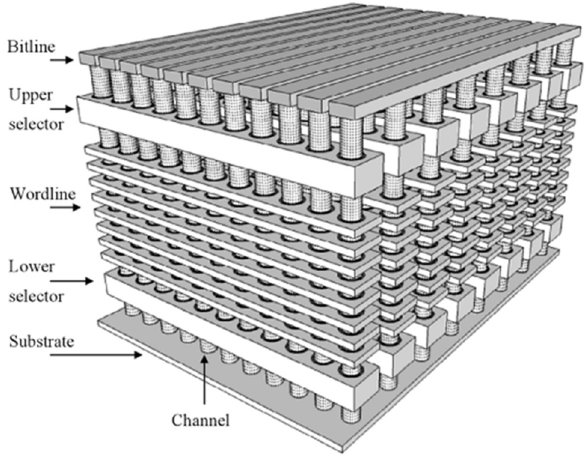
Figure 5. Flash memory launched 3D scaling in 2014 (source, accessed on 1 August 2015: https://www.samsung.com/semiconductor/global.semi.static/2bit_V- NAND_technology_White_Paper-1.pdf).